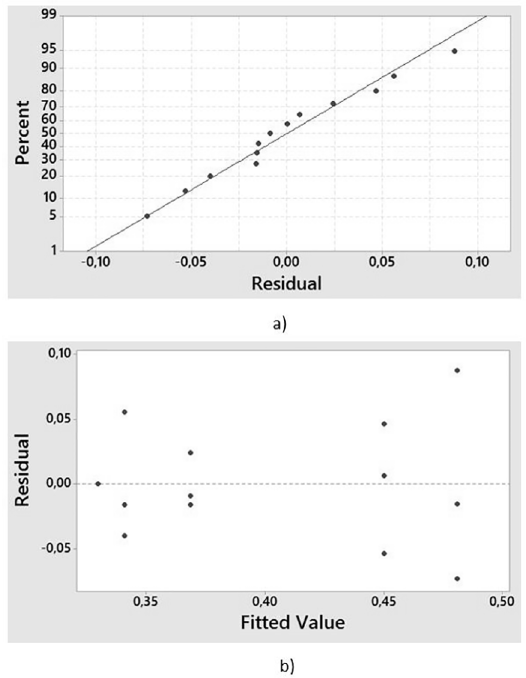
Figure 6. Residual plots for RSM roughness parameter. a) normal probability plot, b) residual vs fitted